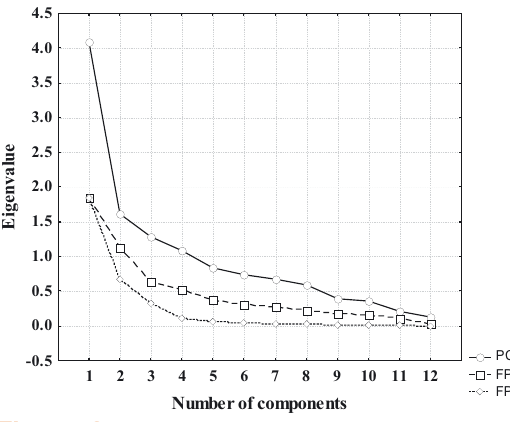
Figure 1. Box and whisker plot of ions concentration.